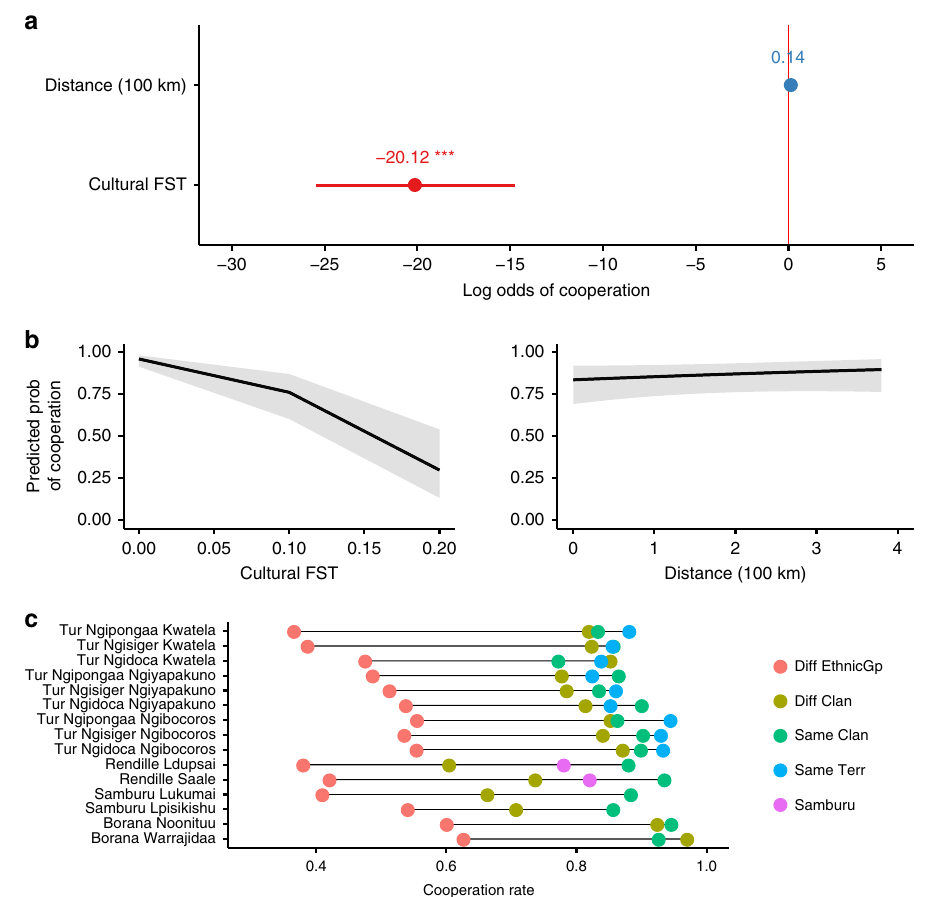
Fig. 3 Predictors of cooperation rates between groups. Logistic regression model of the effect of cultural F ST and geographic distance between actor and target ’ s group, on whether subject endorses the cooperative act. a Log-odds estimates with 95% CI (*** p < .001). b Predicted probabilities of subjects endorsing cooperative act conditioned on cultural F ST value and geographic distance between actor and target ’ s group. c Average rate of endorsement of cooperative act by vignette condition for each subpopulation. For the Turkana (Tur) there are a minimum of 12 subjects in each vignette condition per clan per territorial section. For the Rendille, Samburu and Borana there are a minimum of 17 subjects per clan in each vignette condition. Source data are provided as a Source Data fi